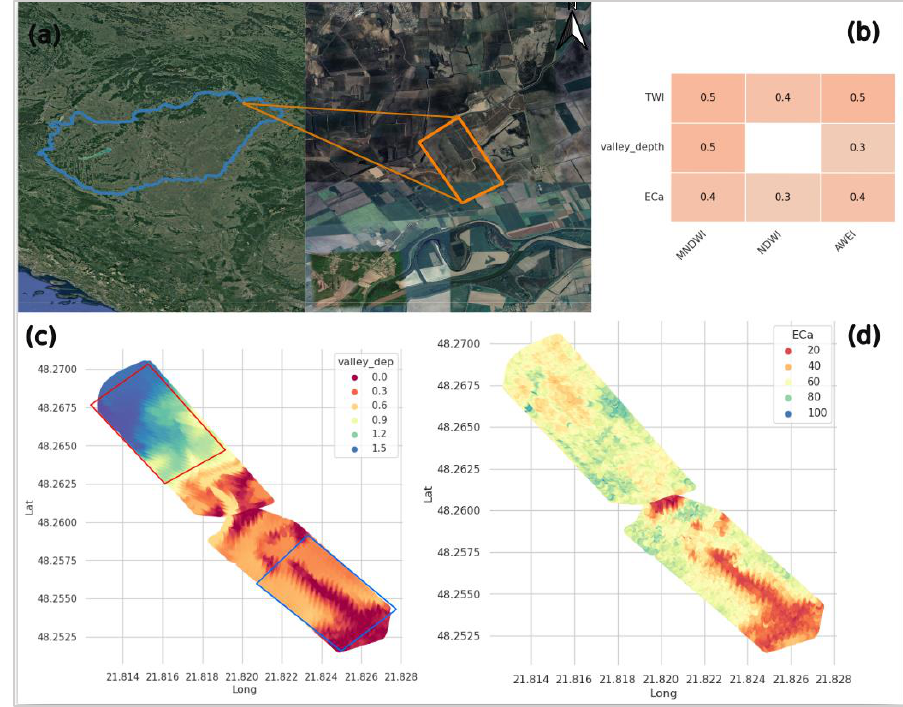
Figure 1. ( a ) Overview map of the study region with google satellite image in the background. The blue color boundary indicates the country’s (Hungary) border, and the orange rectangle indicates the location of the investigated field. ( b ) Pearson correlation coefficients among hydrogeomorphic parameters of the investigated field. Blank cells indicate non-significant correlations, p ≤ 0.05. ( c ) Valley depth distribution of the field as a topographic feature influencing water flows across the field. The red and blue rectangles indicate the upper and lower parts of the field, respectively. ( d ) Map of the apparent electrical conductivity of the investigated field.